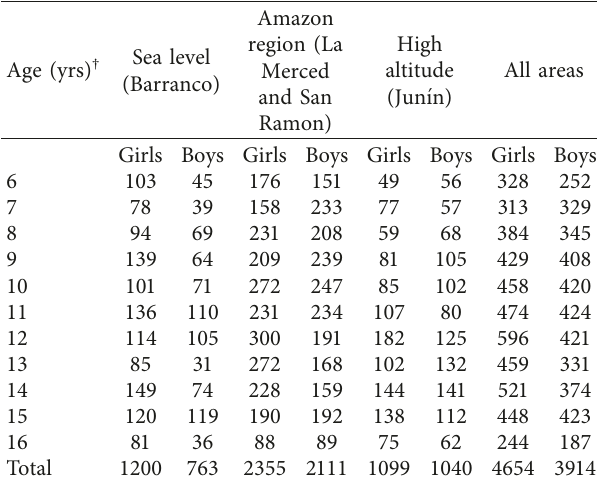
Table 2: Children and adolescents sampled in the three geo- graphical areas of the central region of